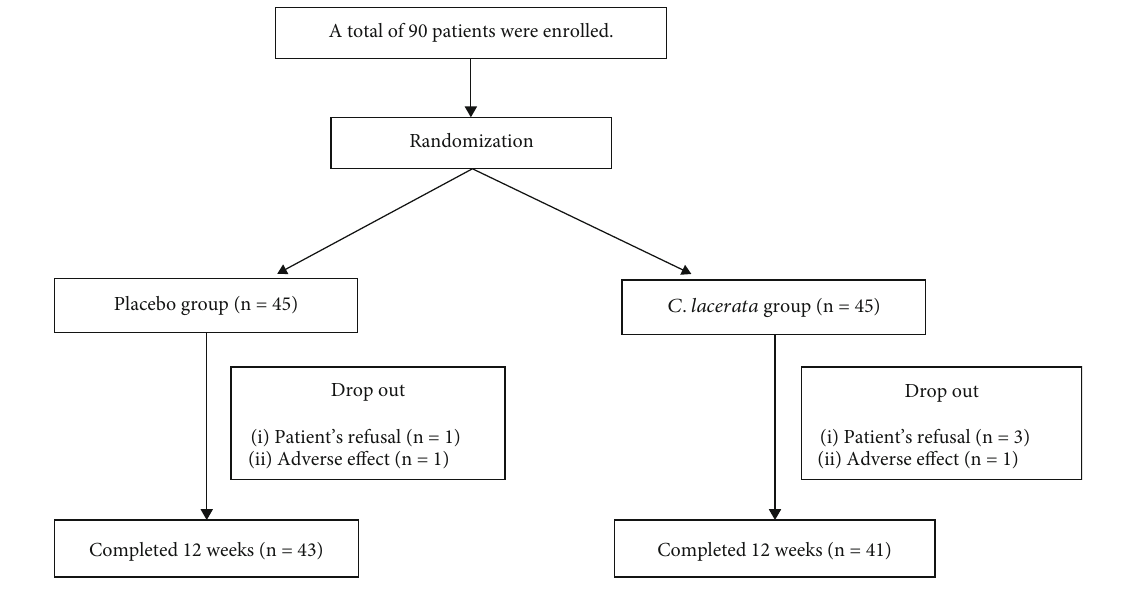
Figure 1: Flowchart of the clinical Table 1: Subject characteristics at baseline.